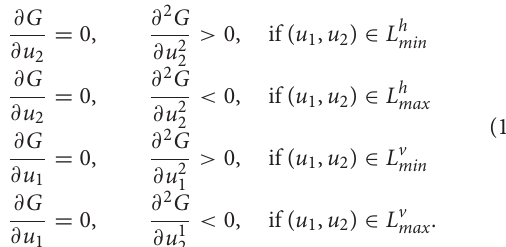
, S a , S a , and S a 1 13 4 16